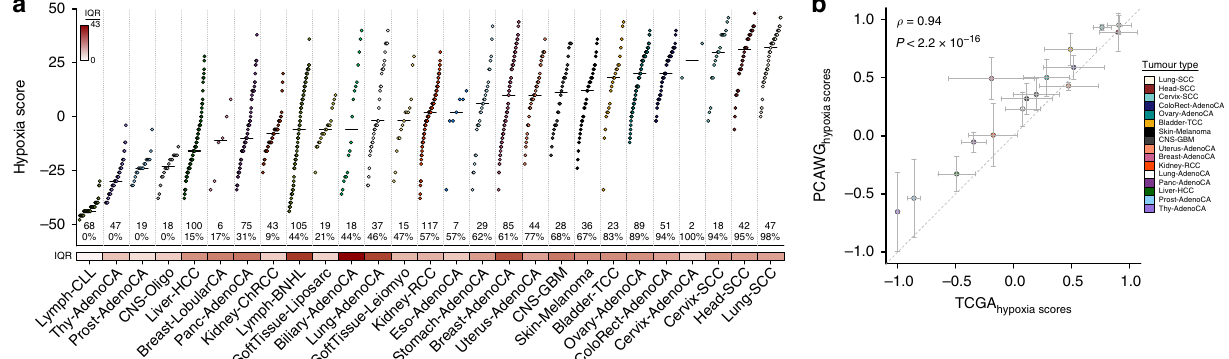
Fig. 1 The pan-cancer landscape of tumour hypoxia. We quanti fi ed tumour hypoxia in 1188 independent tumours spanning 27 different cancer types. a Hypoxia scores for 27 types of cancer, based on the Buffa mRNA abundance signature. Cancer types are sorted by the median hypoxia score (horizontal black line) for each cancer type. Each dot represents one tumour. Sample sizes for each cancer type are listed near the bottom along with the percent of tumours that have elevated hypoxia (hypoxia score > 0). The variability in hypoxia within cancer types was measured by the interquartile range (IQR), shown along the bottom. The IQR was particularly high in biliary adenocarcinoma (IQR = 43.0; Biliary-AdenoCA), lymphoid B-cell non-Hodgkin ’ s lymphomas (IQR = 36.0; Lymph-BNHL), lung adenocarcinoma (IQR = 34.0; Lung-AdenoCA) and breast adenocarcinoma (IQR = 32; Breast-AdenoCA). By contrast, chronic lymphocytic leukaemia (IQR = 2.0; Lymph-CLL) and thyroid adenocarcinoma (IQR = 11.0; Thy-AdenoCA) showed less variance in hypoxia score. b Analysis of hypoxia between 16 comparable cancer types in PCAWG and TCGA (Spearman ’ s ρ , AS89). Dots represent the mean of the scaled median hypoxia scores from three different mRNA-based hypoxia signatures. Error bars represent the standard deviation of the scaled median hypoxia scores. Overall, the pan-cancer quanti fi cation of hypoxia between the PCAWG and TCGA datasets shows strong agreement.